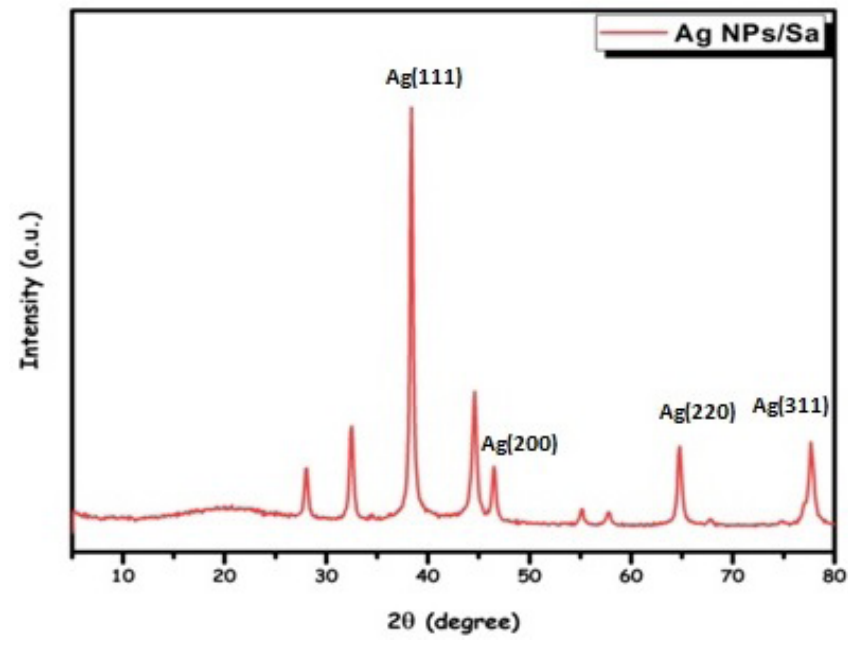
FIGURE 3 - XRD pattern of Ag